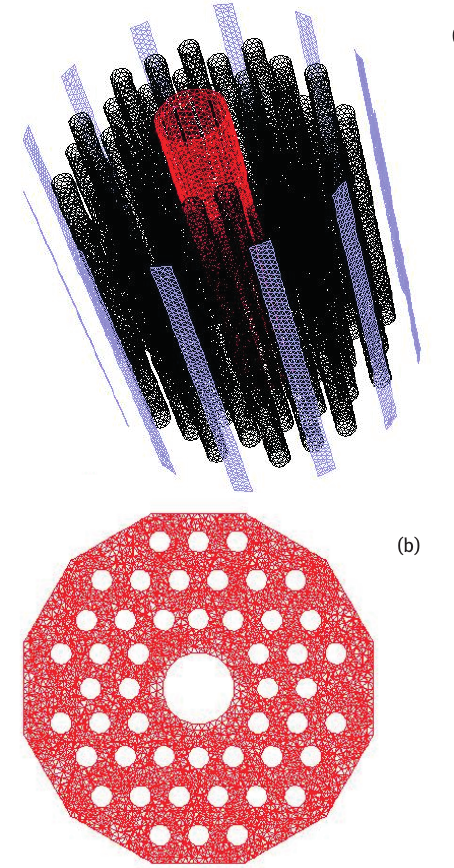
Figure 2: Geometry and numerical mesh of the 48 anode-supported SOFC stack with indication of the air inlets (blue) and air outlet (red tube) (a), top view of the fuel cell distribution at the inlet surface of the stack with mesh (b).